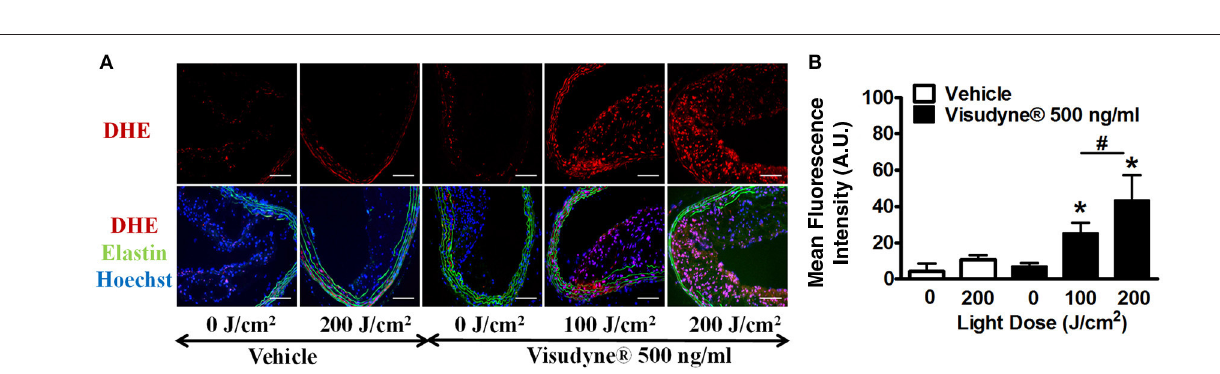
Photofrin (Hsiang et al., 1995) or 5-aminolevulinic